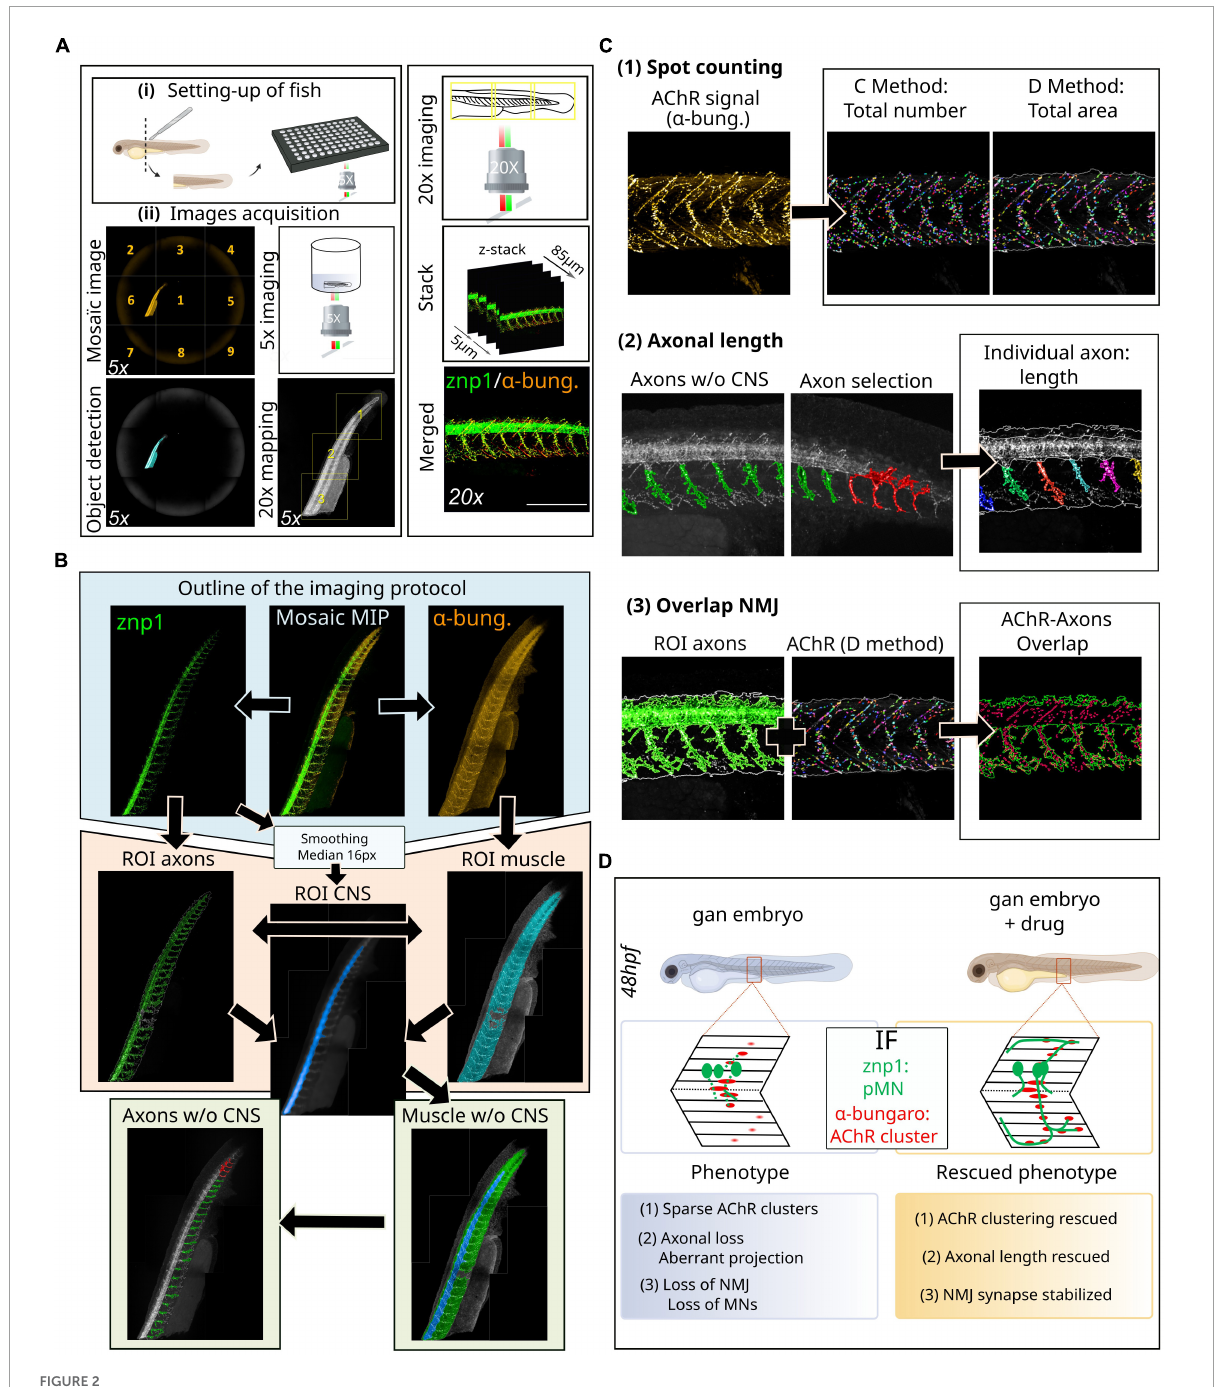
FIGURE2 Novel methodology for high-throughput imaging of the neuromuscular system in the zebrafish. (A) Schematic overview of the setup of 48hpf larvae in 96-well plates (i) for automated detection and image acquisition (ii), from object detection (5x) to stacked images (20x). (B) Outline of the imaging and analytic protocol: representative images of NMJ staining (znp1 in green, α -bungarotoxin in red) within the spinal cord of control larvae, from which several steps of ROI segmentation allow to define the different components of the NMJ. (C) Representative images of the different filters resulting in the segmentation of AChR clusters from α -bungarotoxin staining and individual axon from the znp1 staining, enabling the quantitative assessment of spot counting (1), axonal length (2), and NMJ overlapping compounds within the spinal cord (3). See the Supplementary Figure 1 to assess for the quality of the processing tools for each filter: raw data compared to post-analysis pictures at high magnification. (D) Validation of this methodology in the zebrafish model of giant axonal neuropathy ( gan ). Detailed coverage of NMJ defects in the gan model and identification of hits restoring three parameters of the neuromuscular system, following a high-throughput screening. α -bung, α -bungarotoxin; pMN, primary motor neuron; MN, motor neuron; NMJ, neuromuscular junction; AChR, acetylcholine receptors; MIP, maximum intensity projections; ROI, region of interest; w/o, without; CNS, central nervous